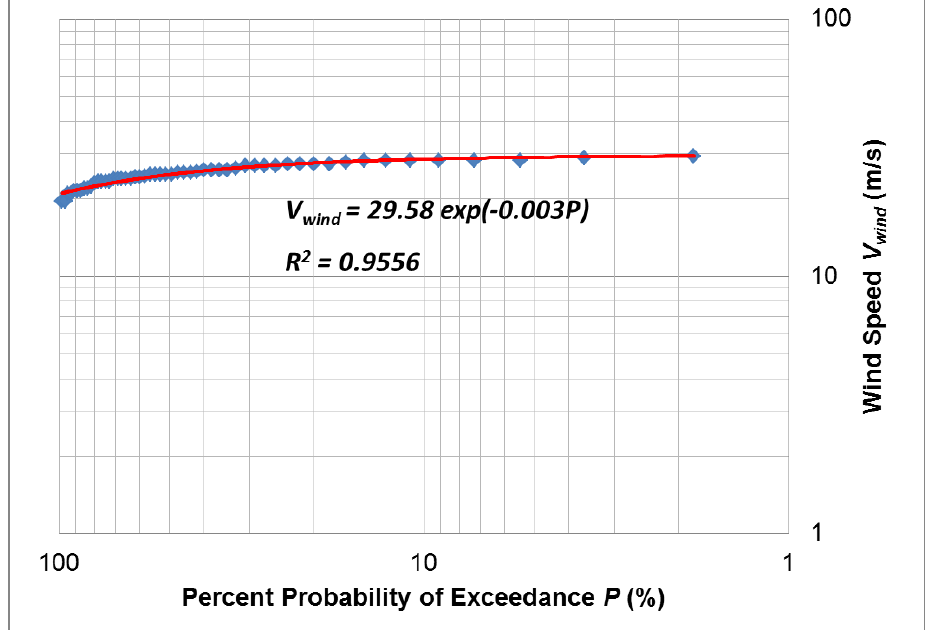
Figure 9. Wind cumulative frequency curve at NCDC station on Whidbey